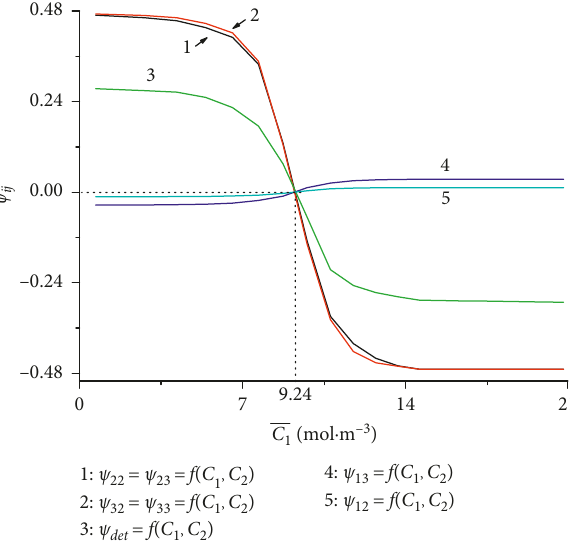
j , r A , B ) for the glucose in (cid:31) ≠